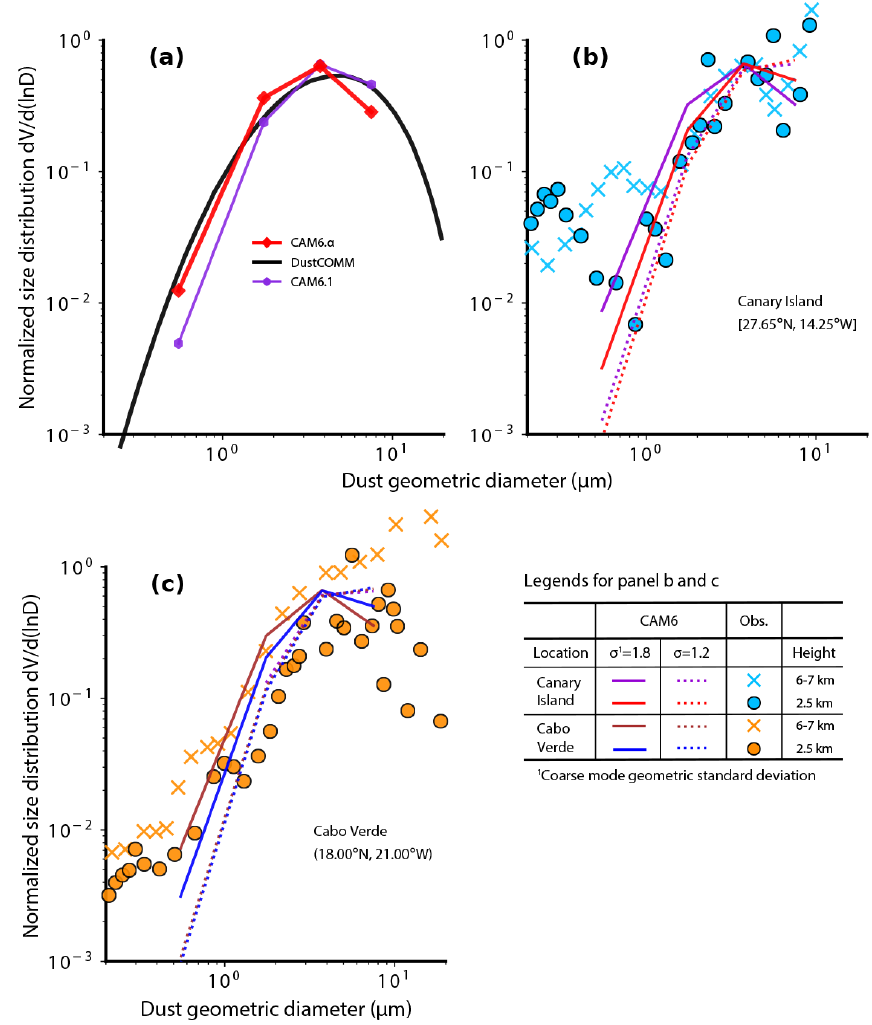
Figure 6. Normalized size distribution of dust between 0.2 and 10µm diameter in the global average (a) , near Canary Island (blue colors in b ; dot: 2.5km; cross: 6–7km; data for June/July 1997 from Otto et al., 2007), and near Cabo Verde (orange colors in c ; dot: 2.5km; cross: 6–7km; data for August 2015 taken from Ryder et al., 2018). The default model, CAM6.1: (purple line); the new model, CAM6. α : (red line); semi-observations: DustCOMM (black line) inverted based on an integration of a global model ensemble and quality-controlled observational constraints on the transported dust size distribution, extinction efficiency, and regional DOD with data taken from Adebiyi et al. (2020). We chose the model layers and grid cells that are closest to the location and atmospheric height, as well as the months, where and when the measurements were made for